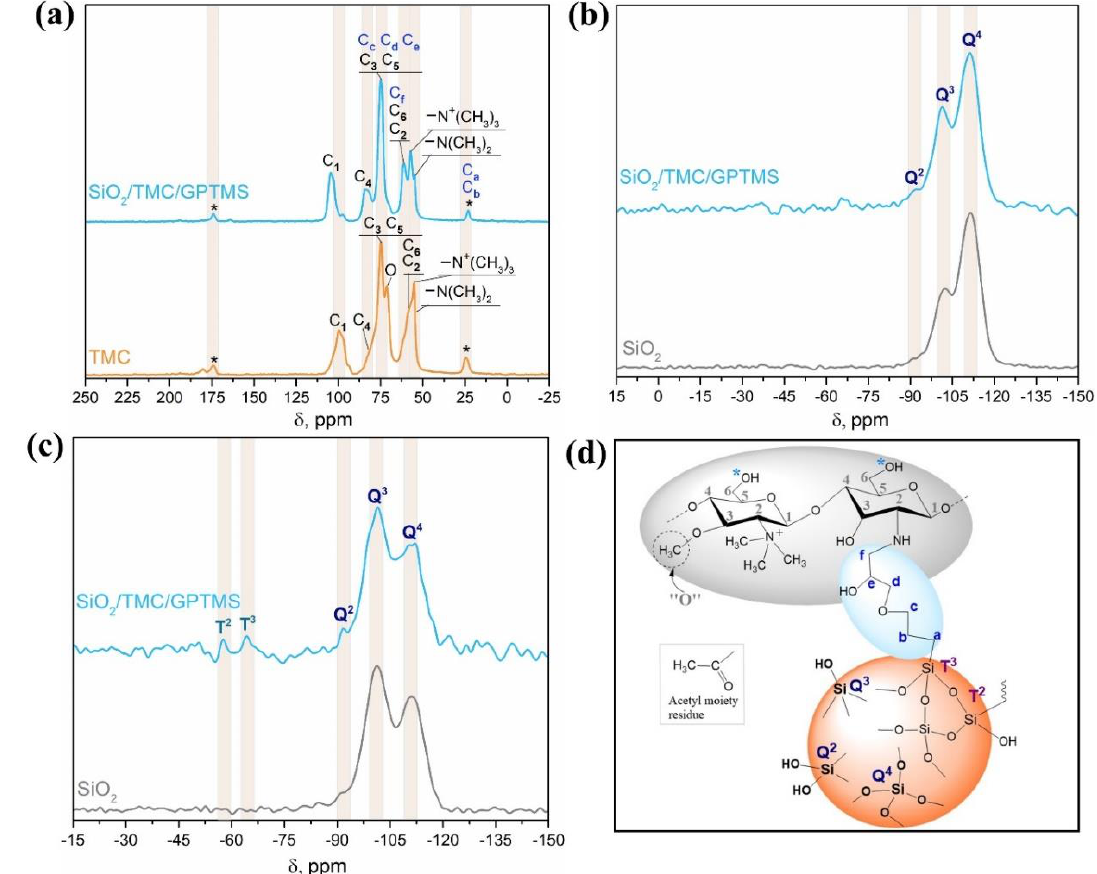
Figure 3. ( a ) 13 C CP/MAS NMR spectra of TMC and SiO 2 /TMC/GPTMS hybrid particles; ( b ) 29 Si MAS NMR spectra and ( c ) 29 Si CP/MAS NMR spectra of SiO 2 and SiO 2 /TMC/GPTMS particles; and ( d ) schematic representation of SiO 2 /TMC/GPTMS particles with the labelling of Si sites according to NMR spectroscopy notation (acetyl groups are not represented in the TMC molecule).